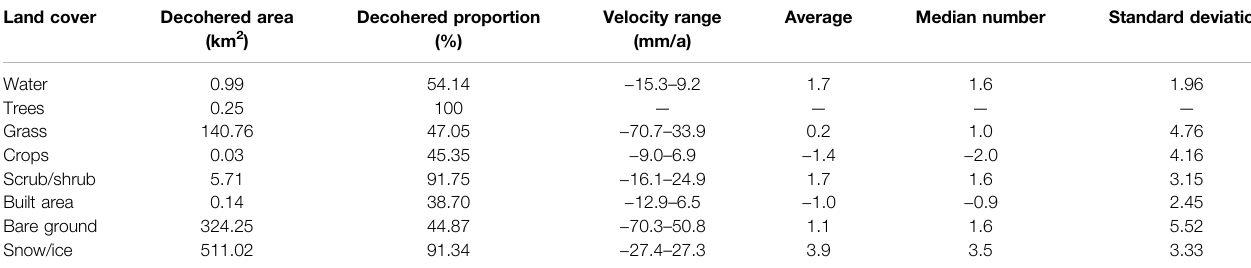
TABLE 2 | Statistics on deformation velocities corresponding to different land covers. Land